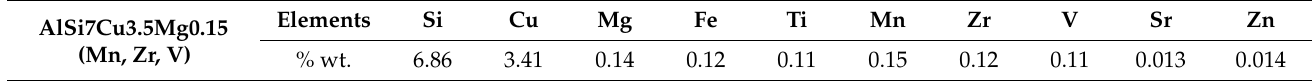
Figure 2. As-cast dendritic microstructure of the AlSi7Cu3.5Mg0.15 (Mn, Zr, V) alloy. Table 1. General chemical composition of cast alloy from cast